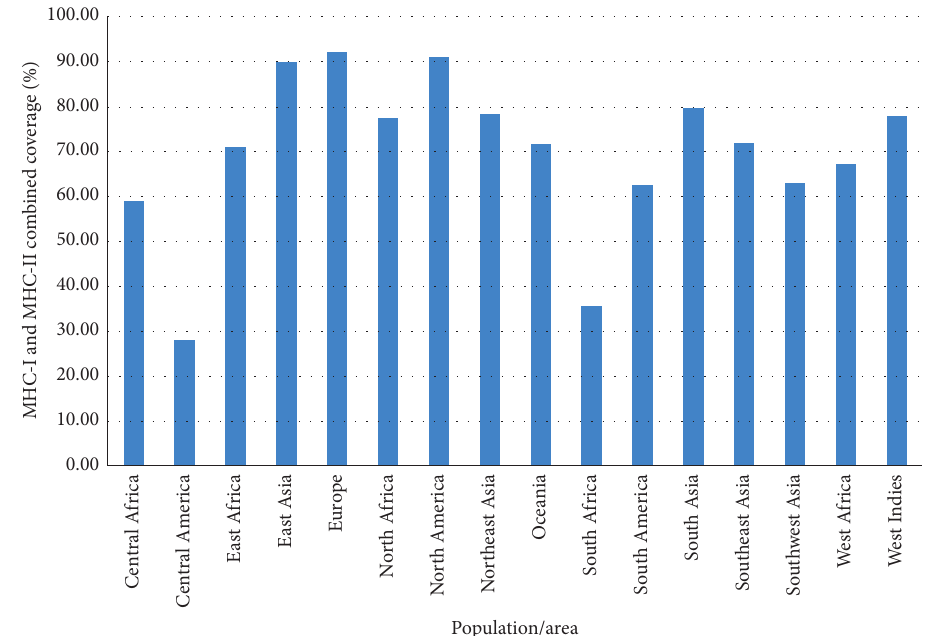
Figure 4: MHC-I and MHC-II epitopes (combined) population coverage among different geographic regions around the